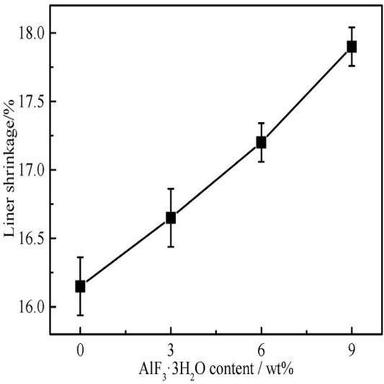
Effect of the AlF3⋅3H2O content on the linear shrinkage of lightweight porous materials.